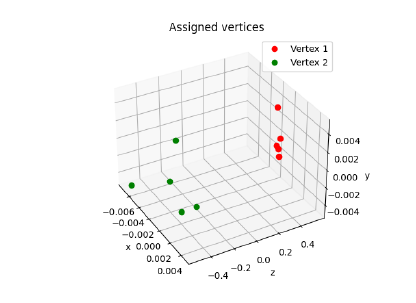
Figure 2: Track to vertex assignment (in colours) for two di ff erent true distances measured in cm between the